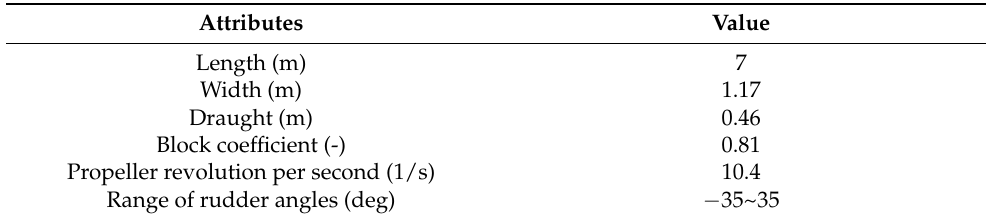
Table 3. Basic parameters of the KVLCC2 within the MMG